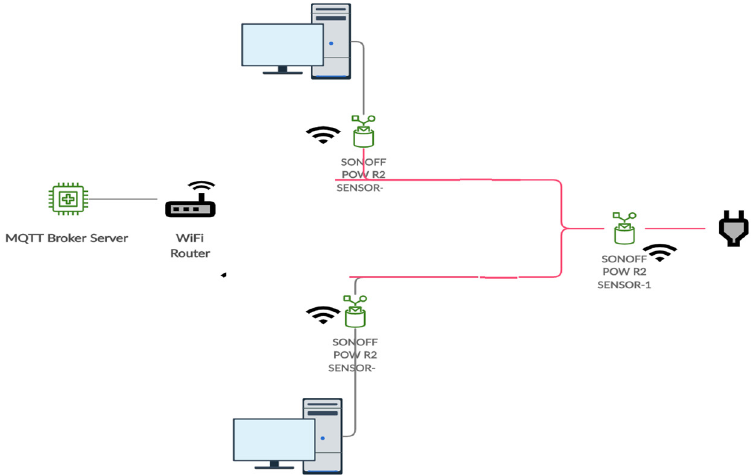
Figure 1. Experiment topology schematic diagram.